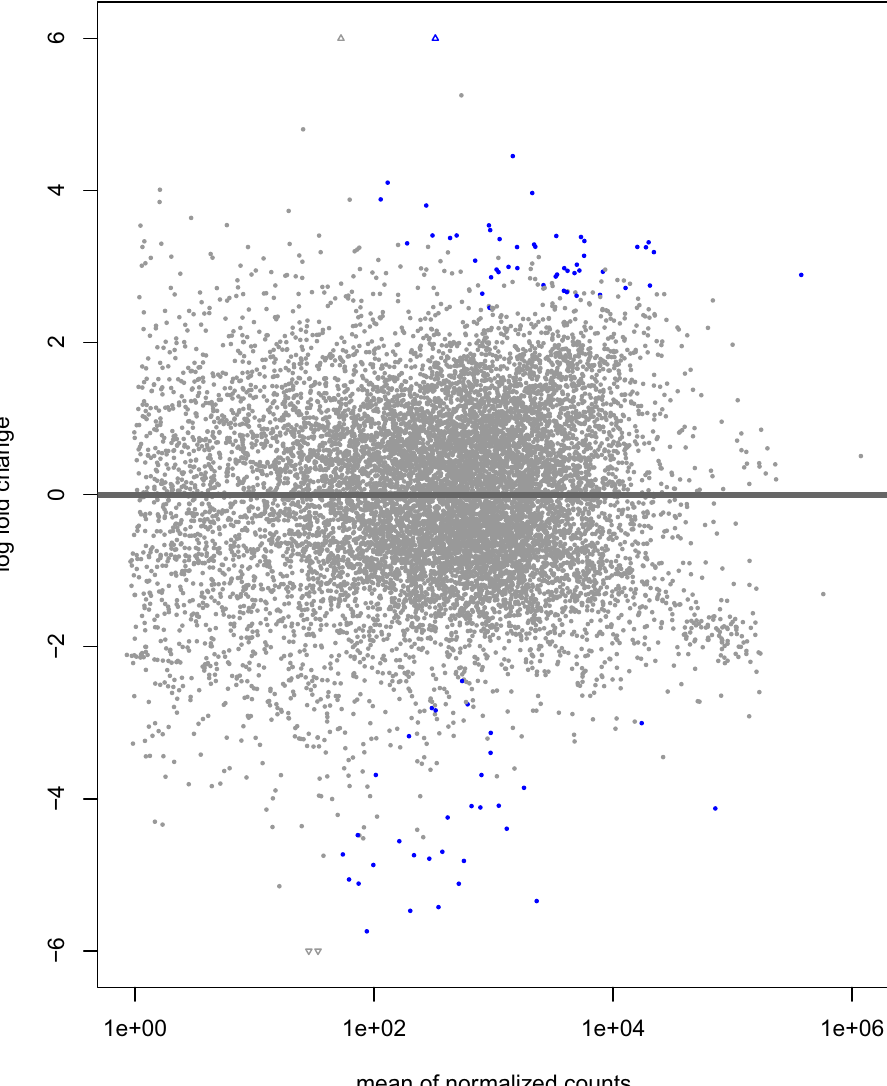
Figure 2. Scatter plot of mRNA log2 fold change of iL3-vs-L1 expression values (on the y-axis) versus the mean of normalized counts (on the x-axis). Dots represent individual transcripts. Blue dots indicate the 81 modulated genes (p-adjusted ≤